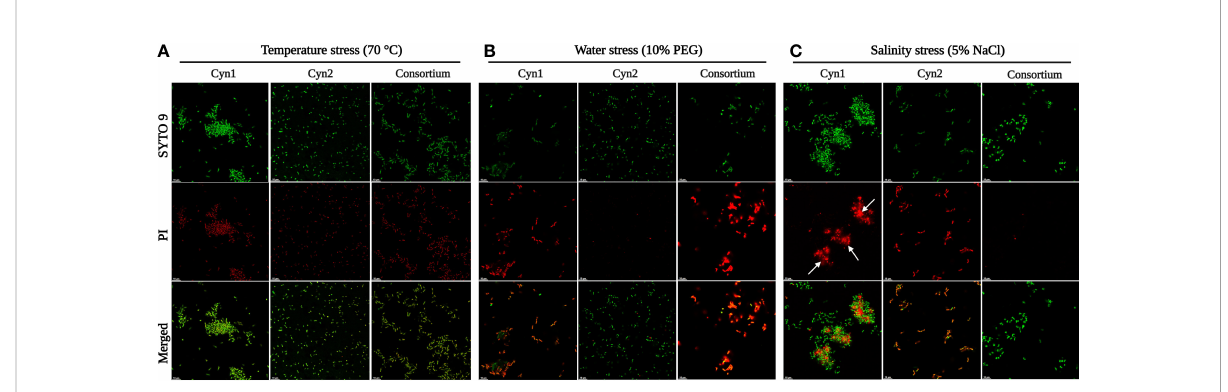
FIGURE 4 Cellular viability analyses of B. proteolyticus Cyn1 and B. safensis Cyn2 under different abiotic stresses via confocal microscopy, where (A) temperature stress, (B) water stress, and (C) salinity stress. The white arrows indicate the presence of eDNA.